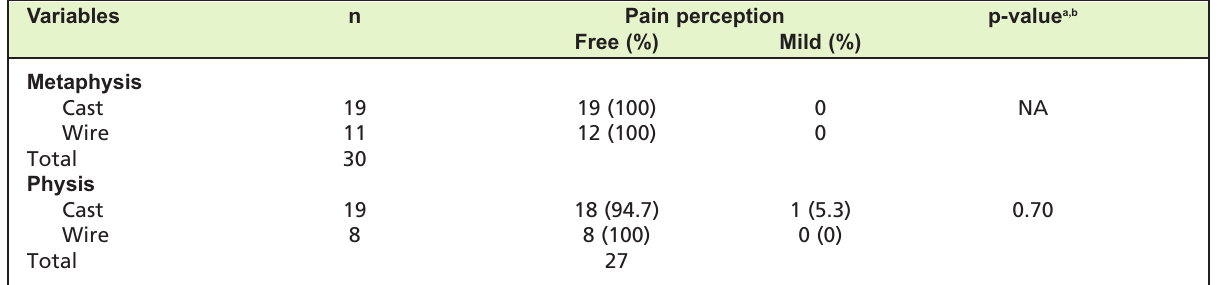
Comparison in pain perception between cast and wire in both metaphysis and physis groups Table III: Variables